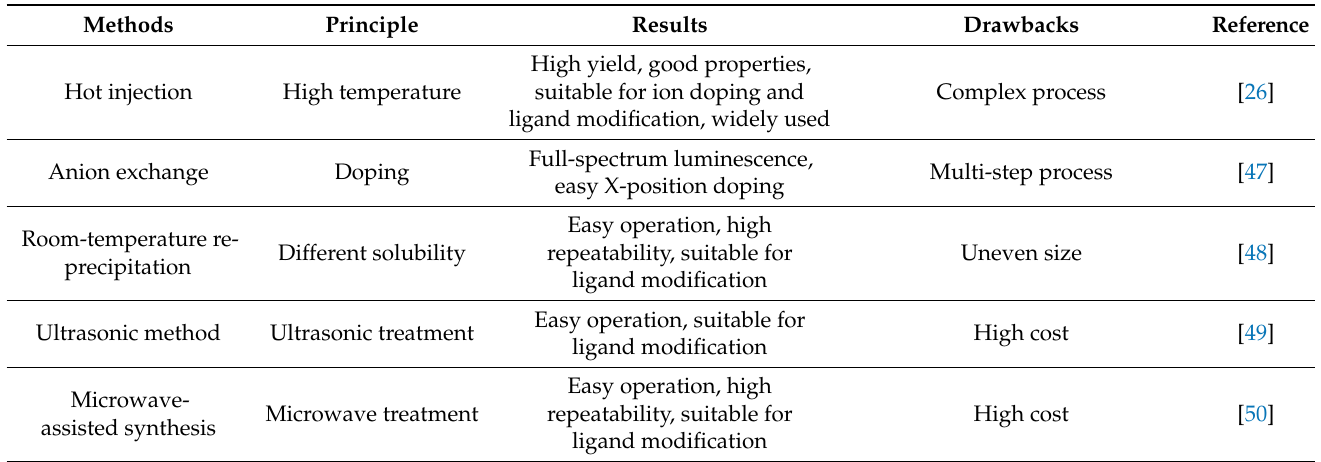
Table 1. The existing synthesis methods of PQDs.